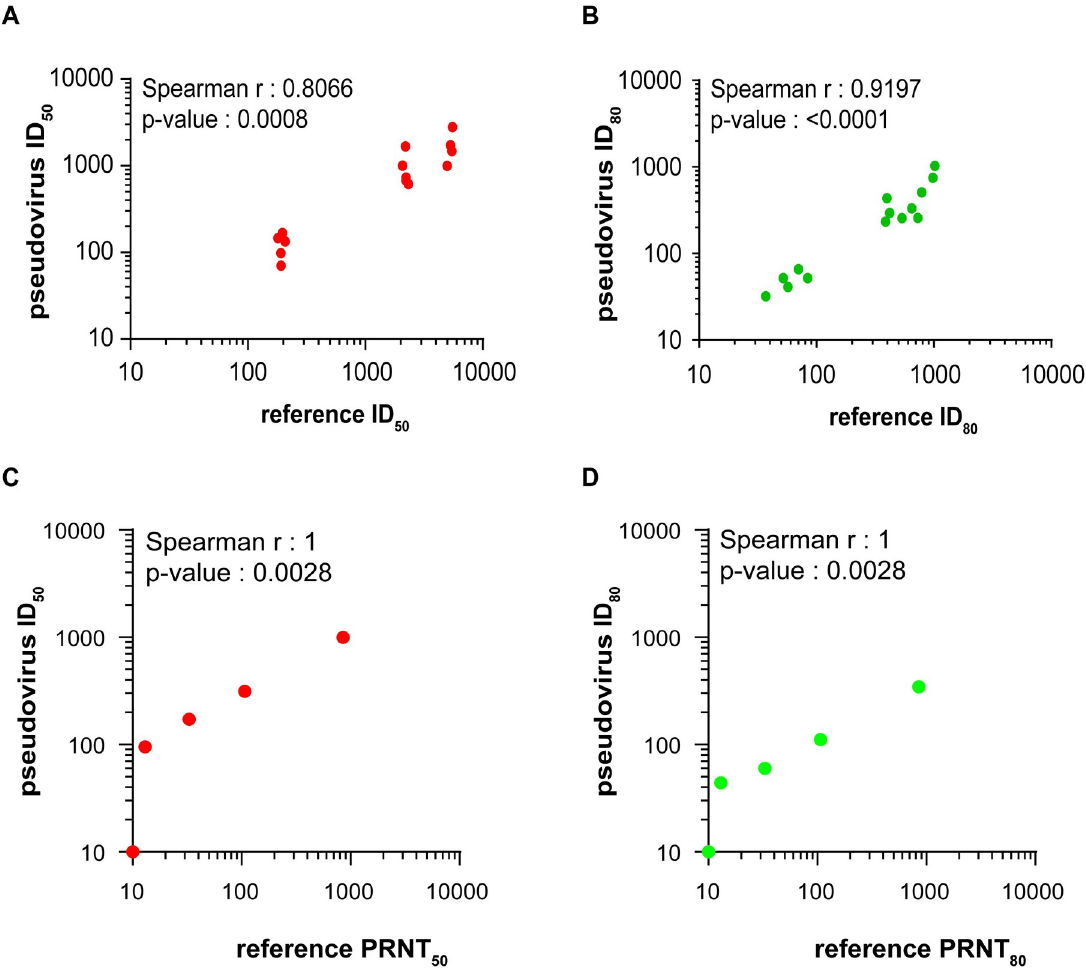
Fig 7. Correlation of neutralization titers between different neutralization assays. Spearman correlation of ID 50 (A and C) or ID 80 (B and D) values comparing titers generated in the present study to (A and B) the focused concordance samples and (C and D) an NIBSC reference standards with reported titers generated by a plaque reduction neutralization (PRNT)